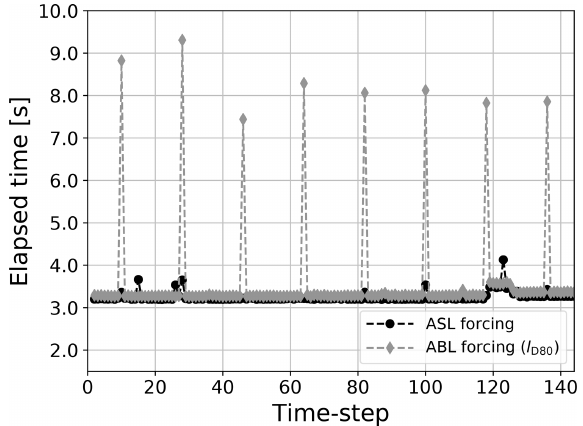
Figure D1. Elapsed time for each time step of a 48h simulation with standard ASL forcing strategy (black circles) and ABL forcing strategy using the l D80 mixing length (gray diamonds). For the two simulations the time step size is (cid:49)t =